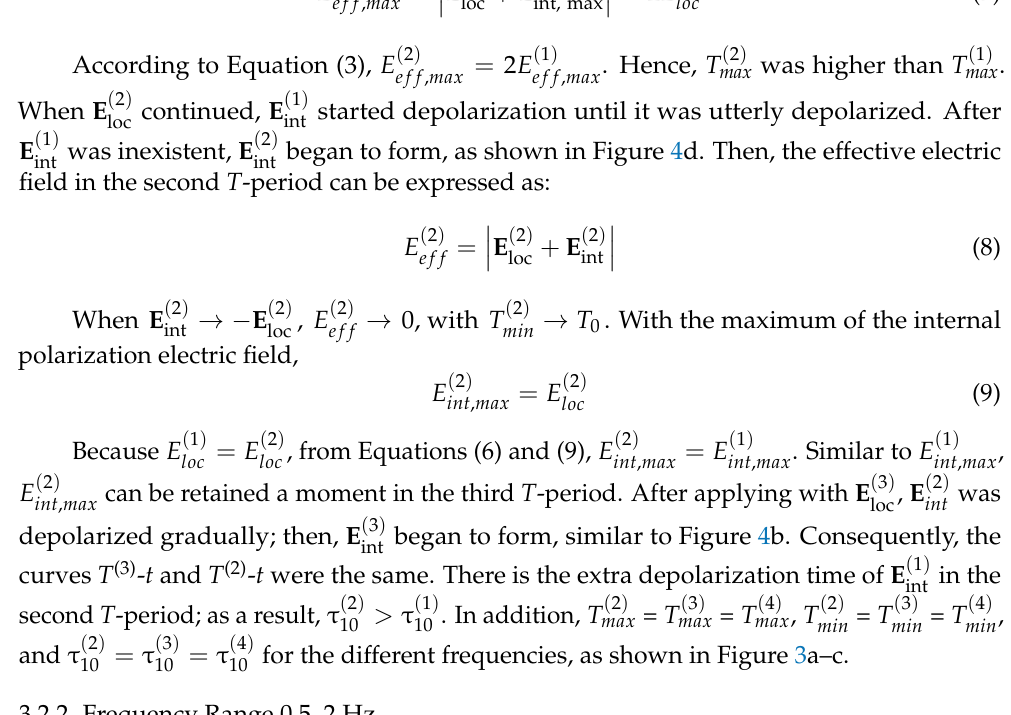
loc(1) int(1) . ( c ) 𝐄 was retained as instant when applying 𝐄